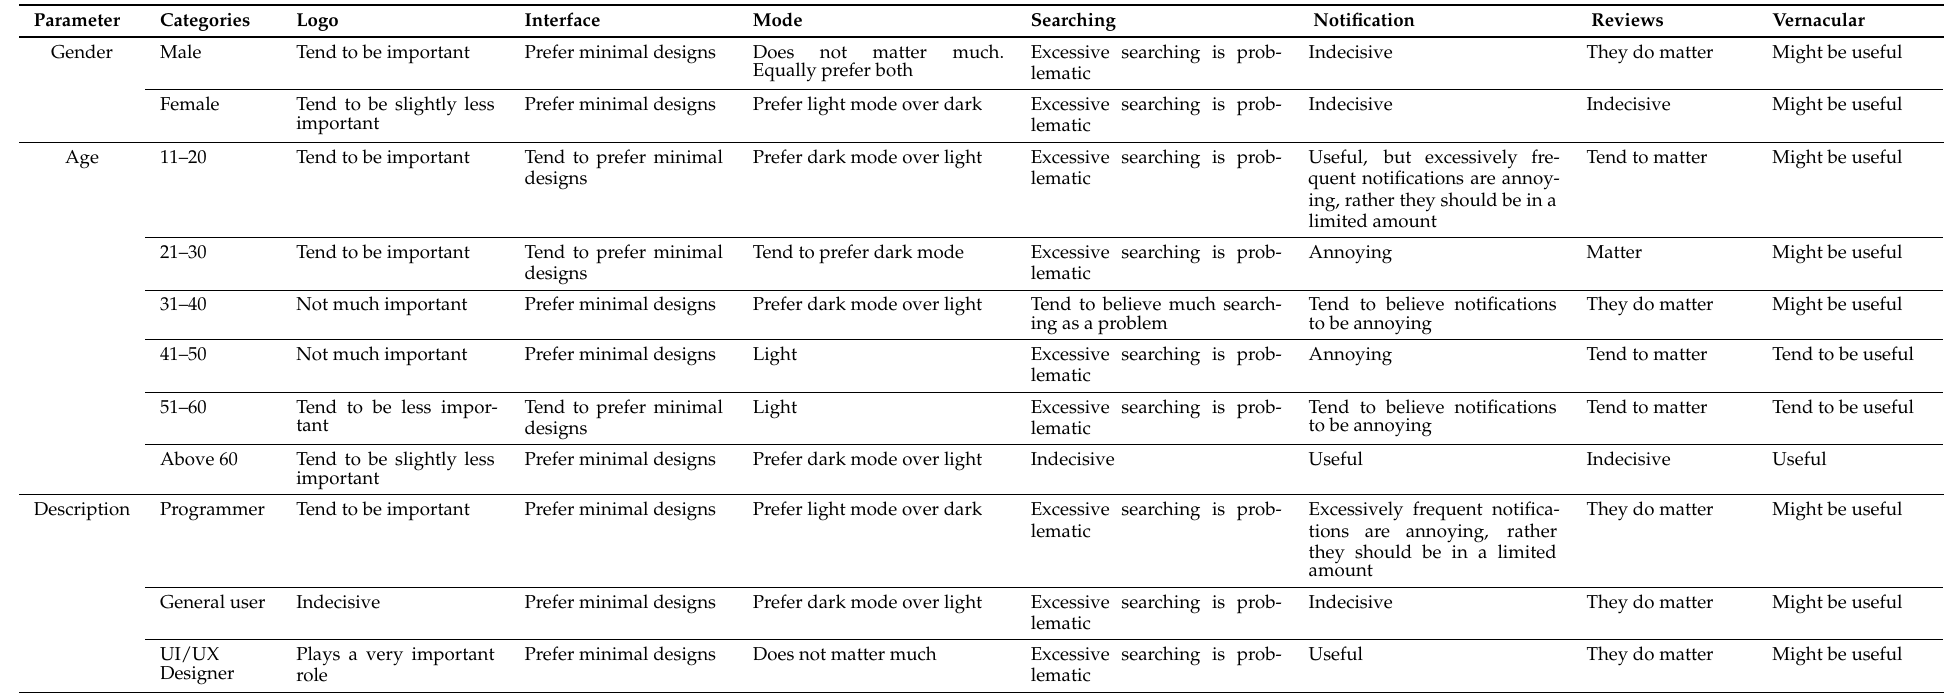
Table 2. Analysed results of